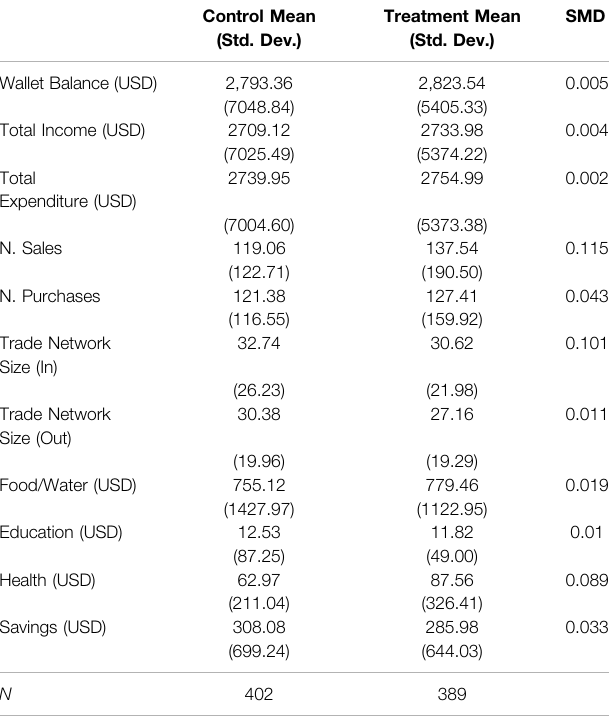
TABLE 3 | Baseline statistics with standardized mean difference (SMD). Control Mean (Std.